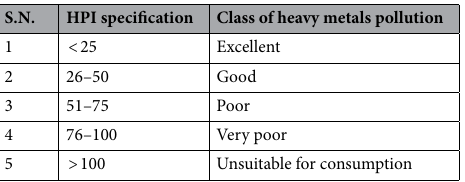
Table 2. Classification of heavy metals pollution based on calculated HPI 40